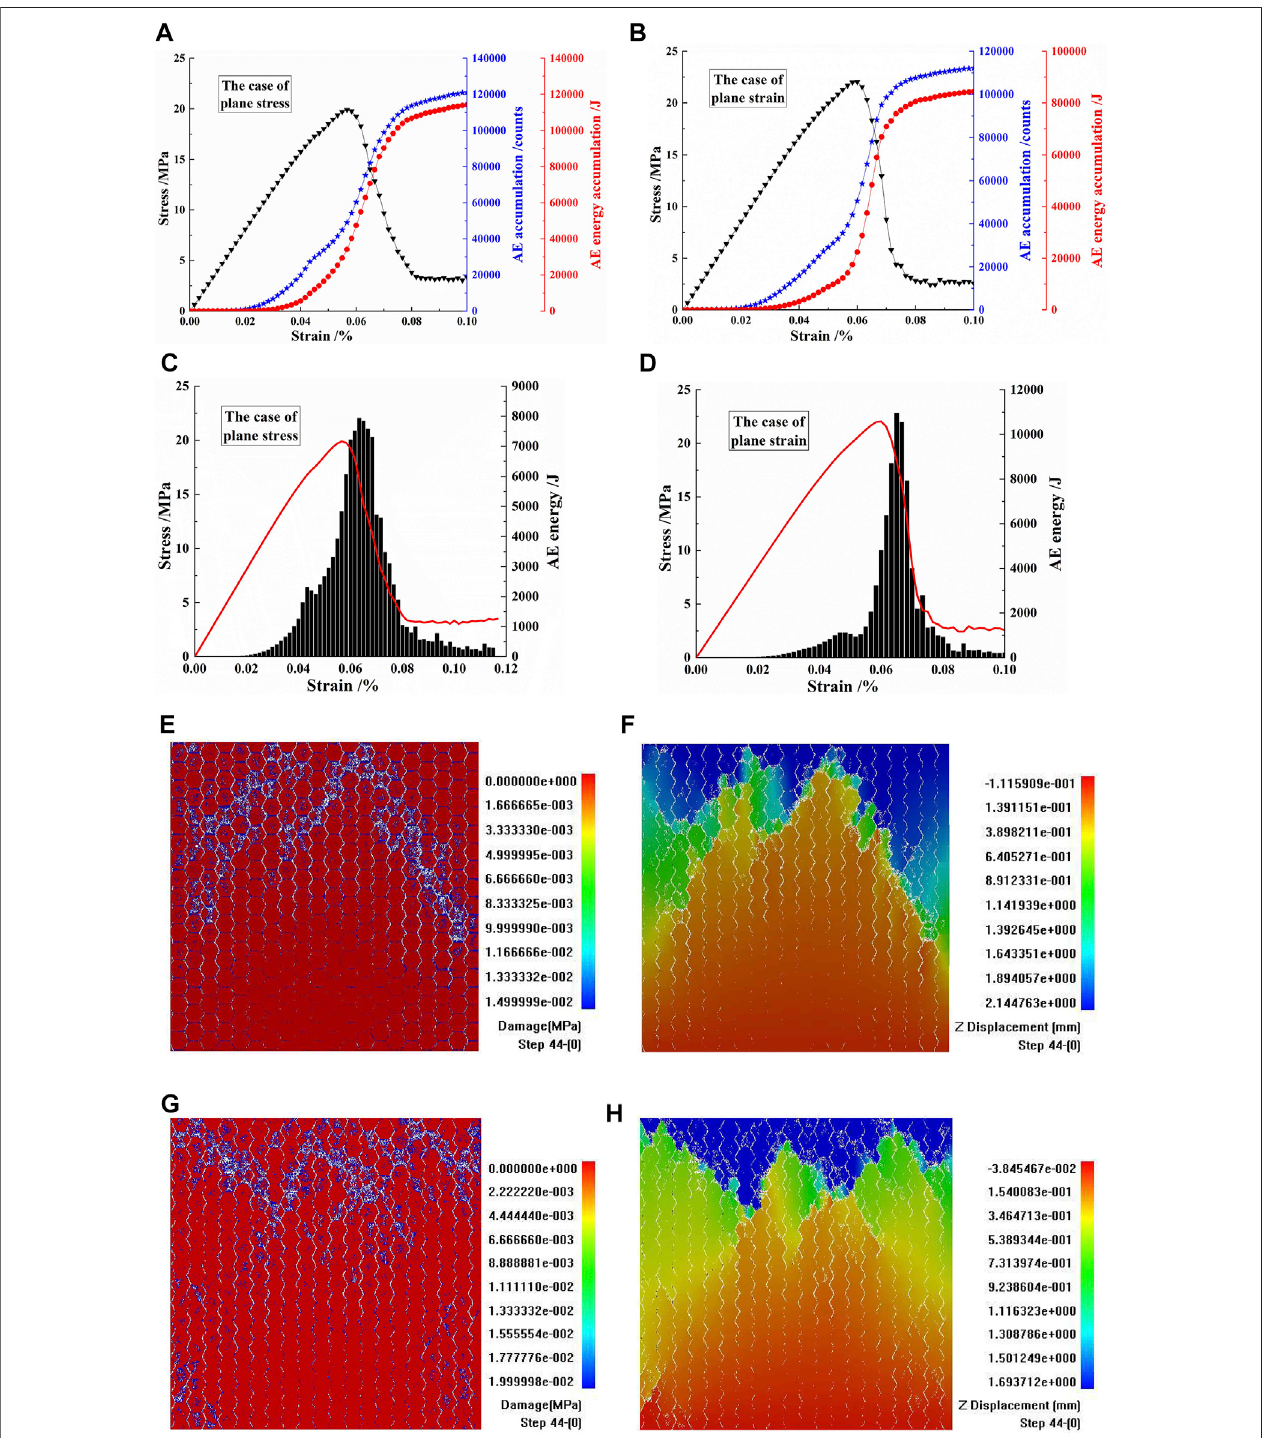
FIGURE8|(A,B) Thethestress – straincurves,acousticemission(AE)accumulations,andAEenergyaccumulationsofcolumnarjointedbasalts(CJBs)indirection I orthogonal to the column axis for the case of plane stress and the case of plane strain, with a con fi ning pressure of 0 MPa. (C,D) The stress – strain curves and AE energies of CJBs for the case of plane stress and the case of plane strain. (E,F) Damage and displacement diagrams for the case of plane stress. (G,H) Damage and displacement diagrams for the case of plane strain.